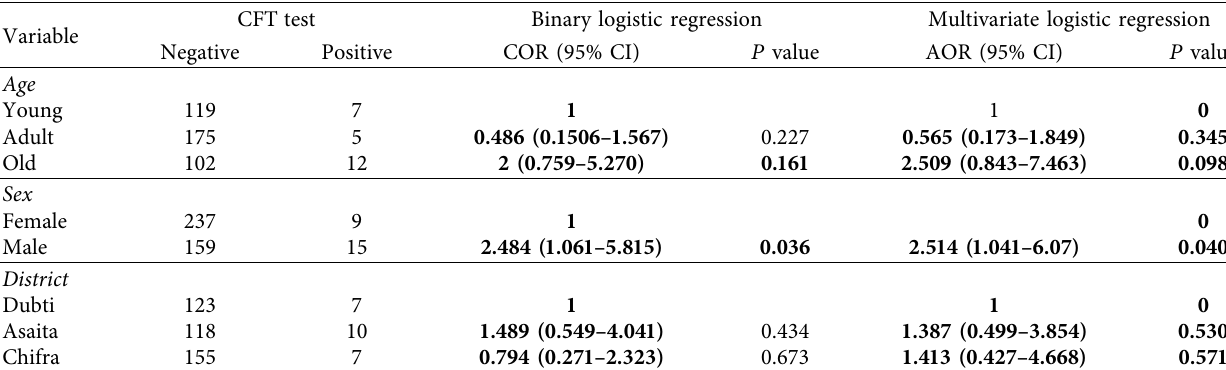
Table 3: Summary of bivariate and multivariate logistic regression analyses.